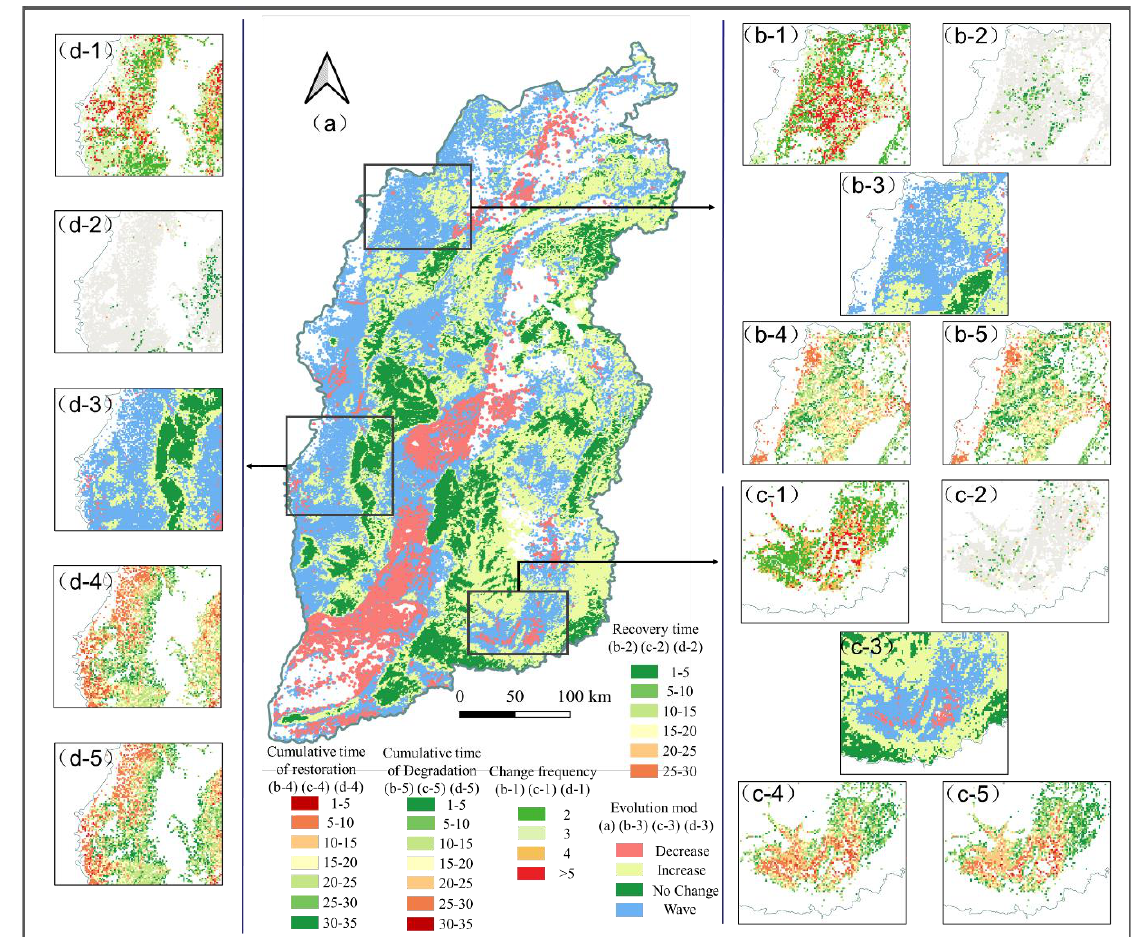
Figure 9. Typical regional forest landscape stability: ( a ) spatial distribution of evolution mode; ( b ) spatial distribution of evolution modes and landscape stability evaluation index for wave mode in Northwest Shanxi; ( c ) spatial distribution of evolution modes and landscape stability evaluation index for wave mode in Northwest Shanxi; ( d ) spatial distribution of evolution modes and landscape stability evaluation index for wave mode in the west of the Luliang Mountains.